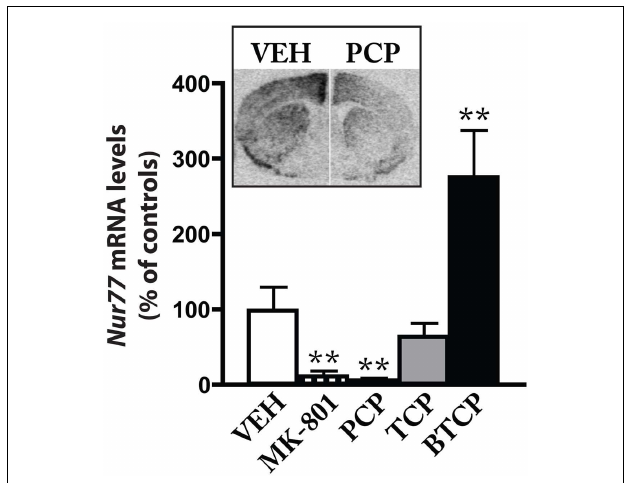
FIGURE 3 | NMDA antagonists reduced basal Nur77 expression. Levels of Nur77 mRNA (expressed as% of control) were measured in the ventrolateral portion of the striatum after treatment with vehicle (VEH), MK-801 (0.75mg/kg, i.p.), PCP (5mg/kg, i.p.),TCP (0.75mg/kg, i.p.), or BTCP (16mg/kg, i.p.). Histograms represent mean ± SEM (** p < 0.01 vs. VEH, N = 5 per group). Inset: representative autoradiograms showing Nur77 mRNA levels in a left hemi-brain from theVEH group and a right hemi-brain from the PCP